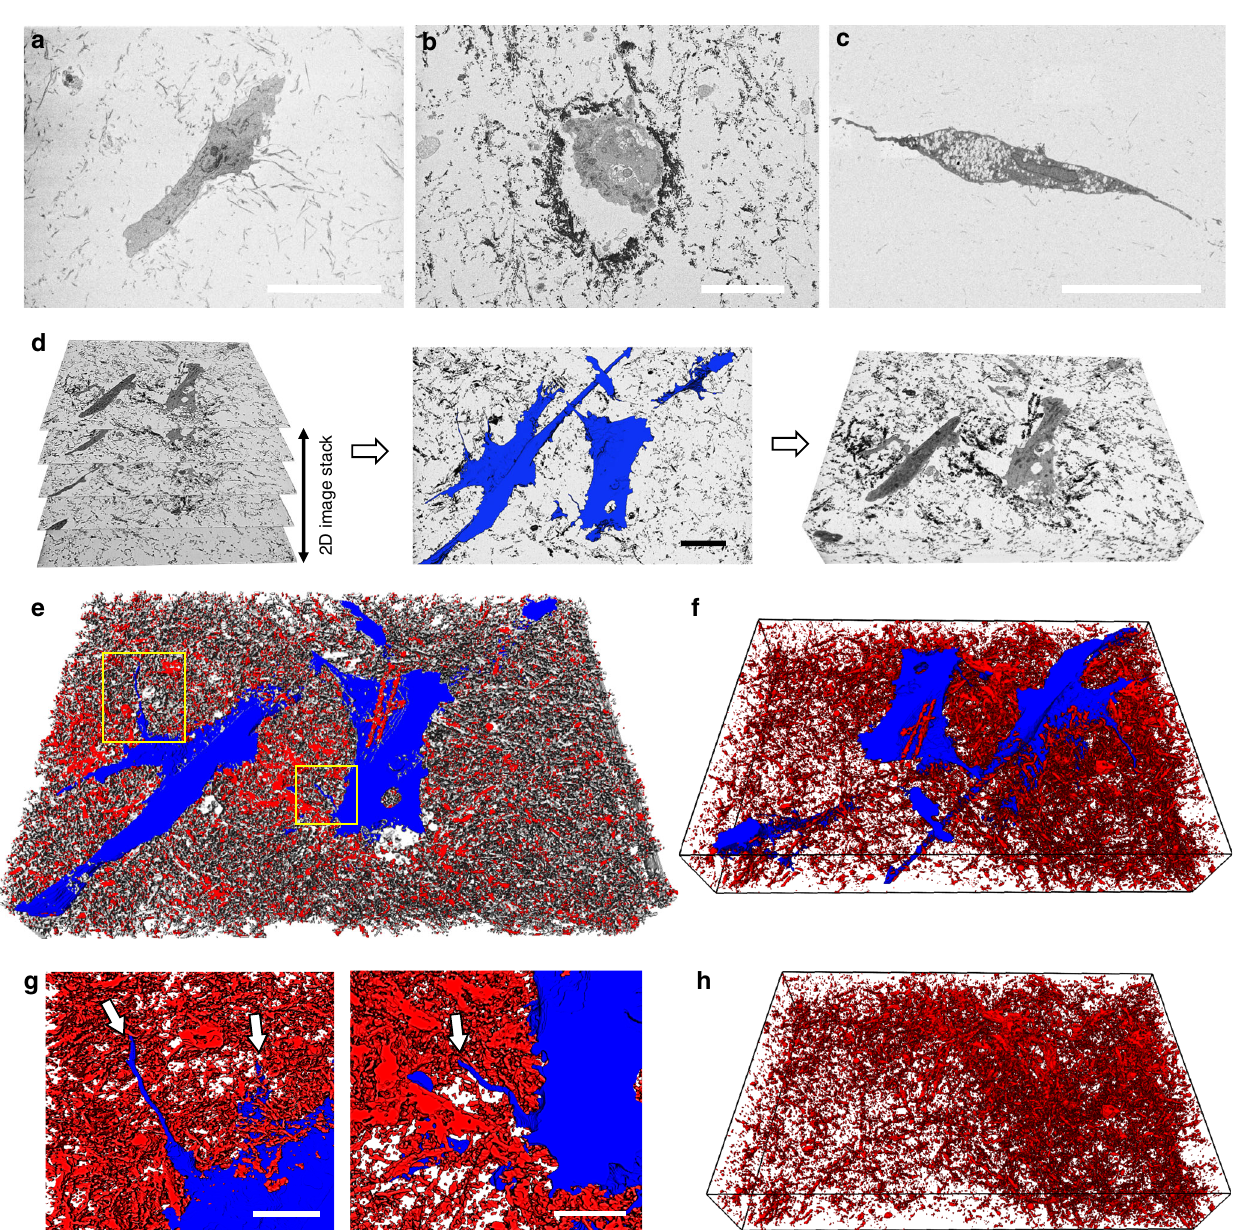
Fig. 4 3D volumetric reconstruction of BSE micrographs obtained via serial block-face SEM. a Matrix surrounding cells in non-mineralized collagen had little backscattered contrast, suggestive of lack of mineralization. b In mineralized hydrogels, the matrix was visibly darker due to the backscattered electron contrast of mineralized fi brils, especially in the matrix immediately surrounding the cells. c Collagen in OIM-treated samples also lacked signi fi cant backscattered electron signal. d Illustration of the serial stacking of 190 60 nm-thin sections, the segmentation of cells (blue) from the surrounding mineralized matrix (middle panel, scale bar: 20 µ m), and visualization of block 3D image (right panel). Arrows in d show narrow dendrite-like cell processes. e 3D-rendered image of mineralized samples showing cells (blue) embedded in mineral (red), with the underlying collagen (gray). f Exclusion of collagen via digital processing in these mineralized samples illustrates the density of mineralized collagen and cells spread within a bed of mineralized matrix. Narrow cell processes (arrows) shown in higher magni fi cation in g appear to extend between mineralized fi brils (Supplementary Movie 2) (scale bar: 10 µ m). h Digital removal of cell bodies from within the mineralized matrix illustrates density of mineral surrounding the cell structures. The total length of the x -axis in all 3D reconstructions ( d , e , f , and h ) is 62 µ